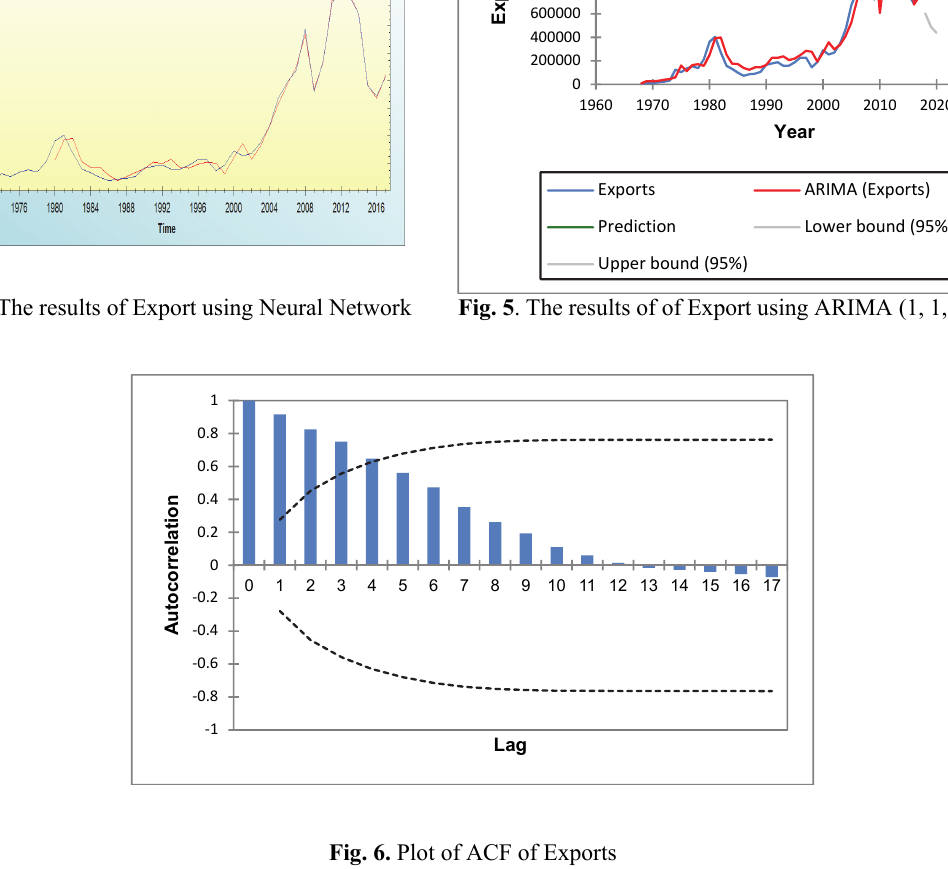
Fig. 6. Plot of ACF of